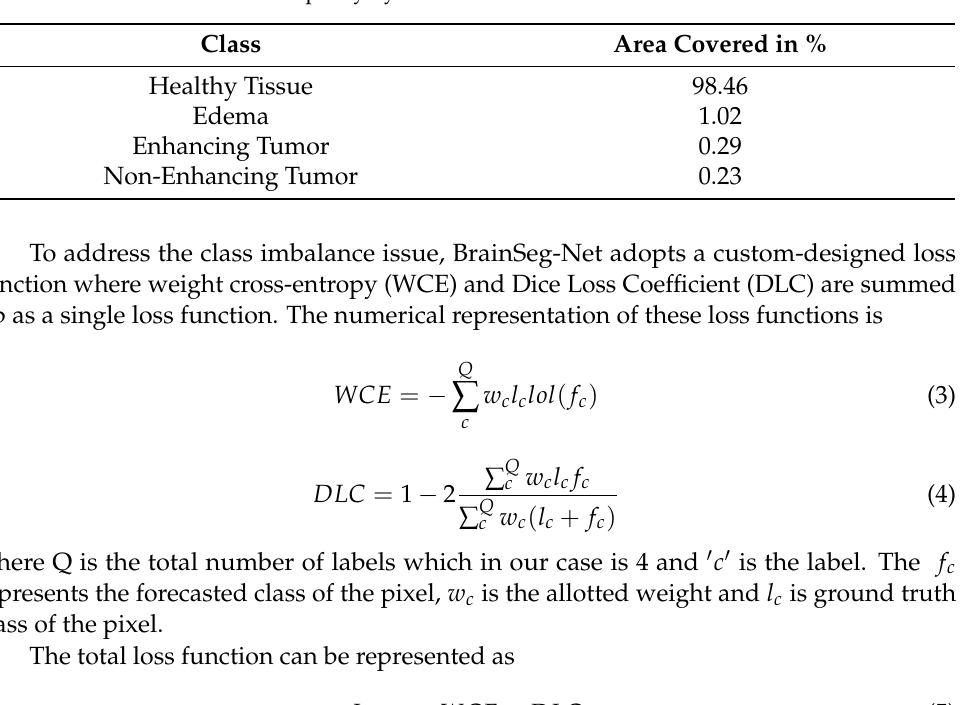
Table 1. Distribution of area occupancy by different classes in brain tumor